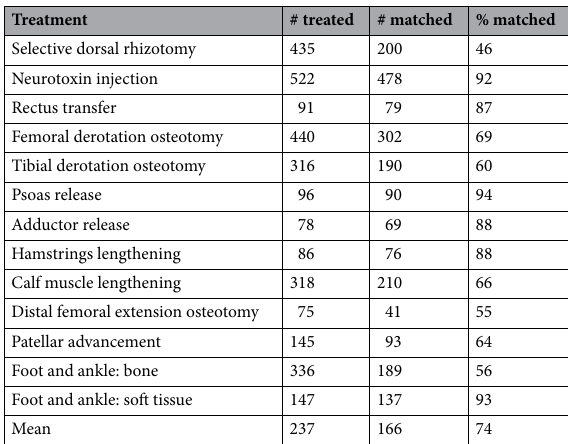
Table 2. Numbers of treated and matched observations.